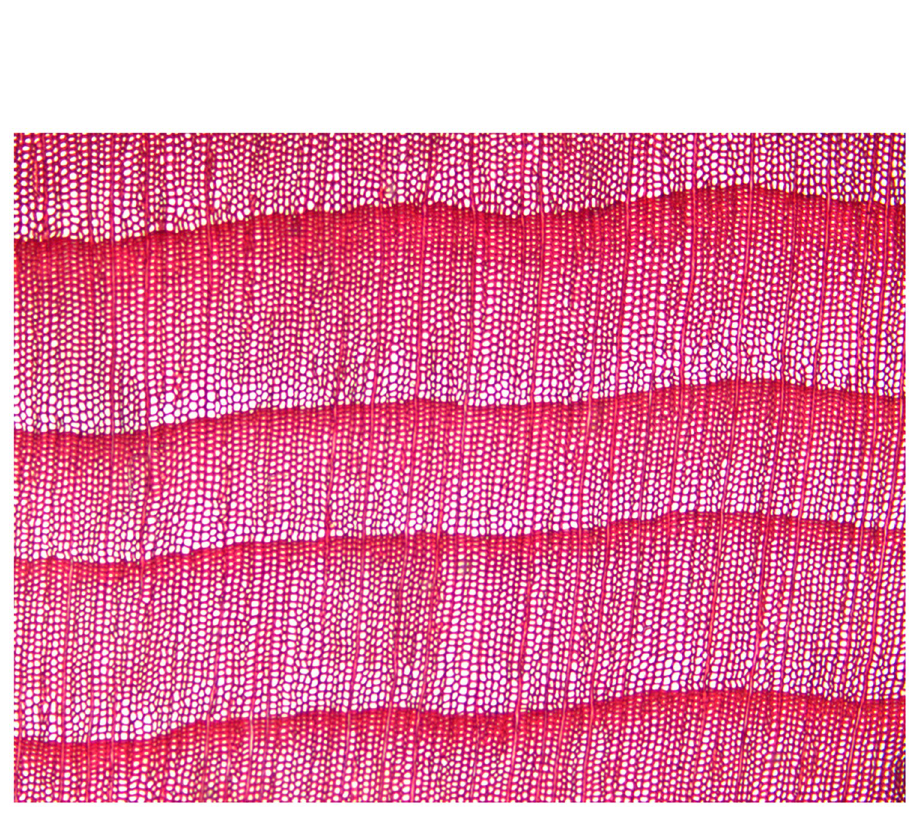
Fig 5. An example of original image for